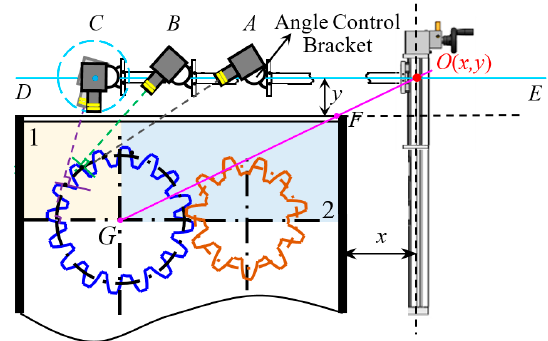
Figure 5. Gear pitting images obtained under various shooting angles.